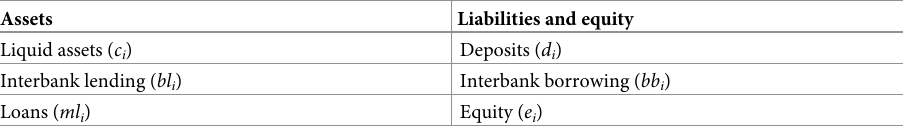
Table 1. The simplified balance sheet of bank i